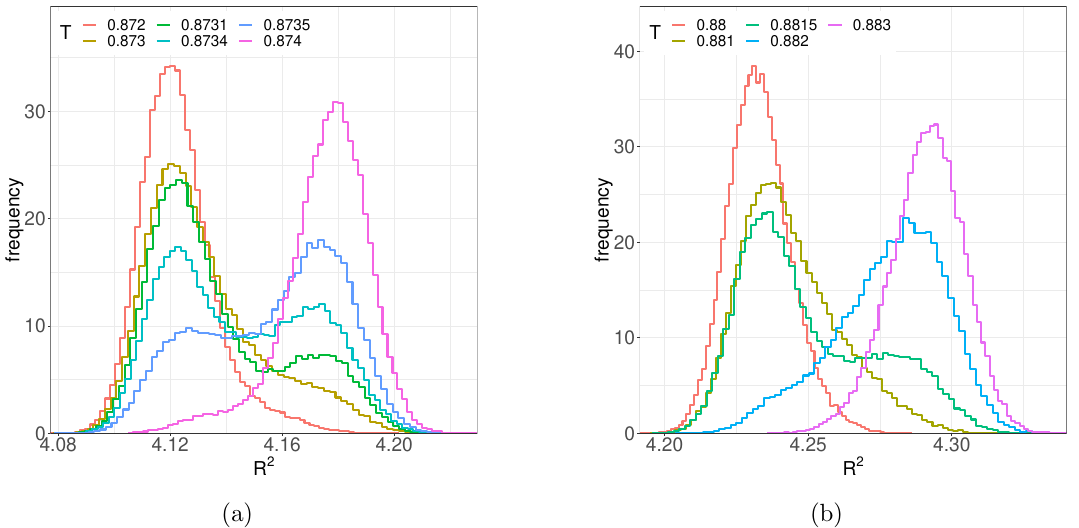
Figure 13. Histograms of R 2 for N = 64, D = 26 for various T : a) L=24, b) L=48.